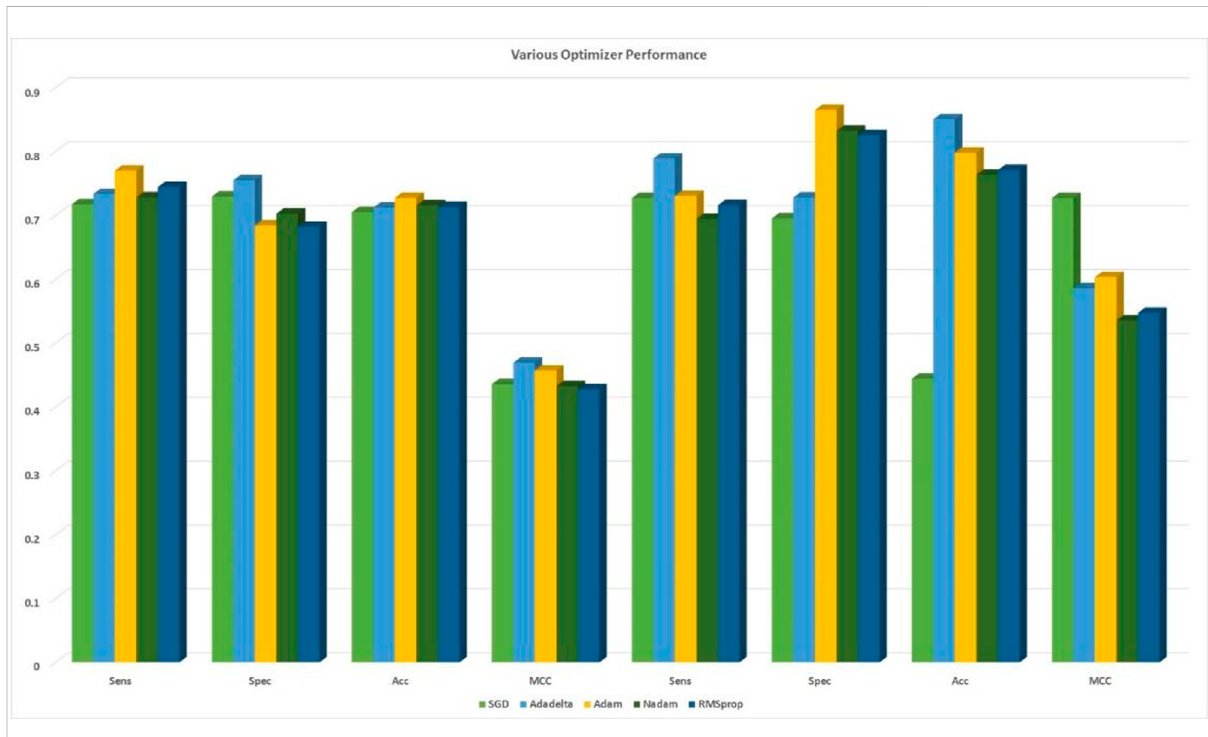
FIGURE 5 Comparison among the fi ve optimizers based on 10-fold cross-validation with cross-validation and independent